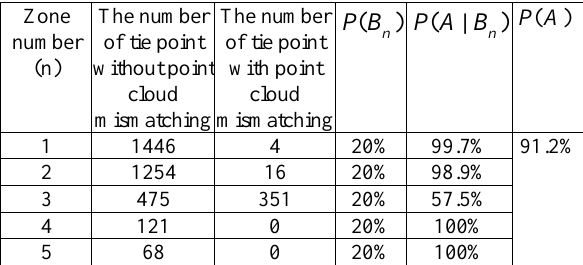
Table 4. Overall accuracy of MLS data adjustment based on the probability of pole-like infrastructure